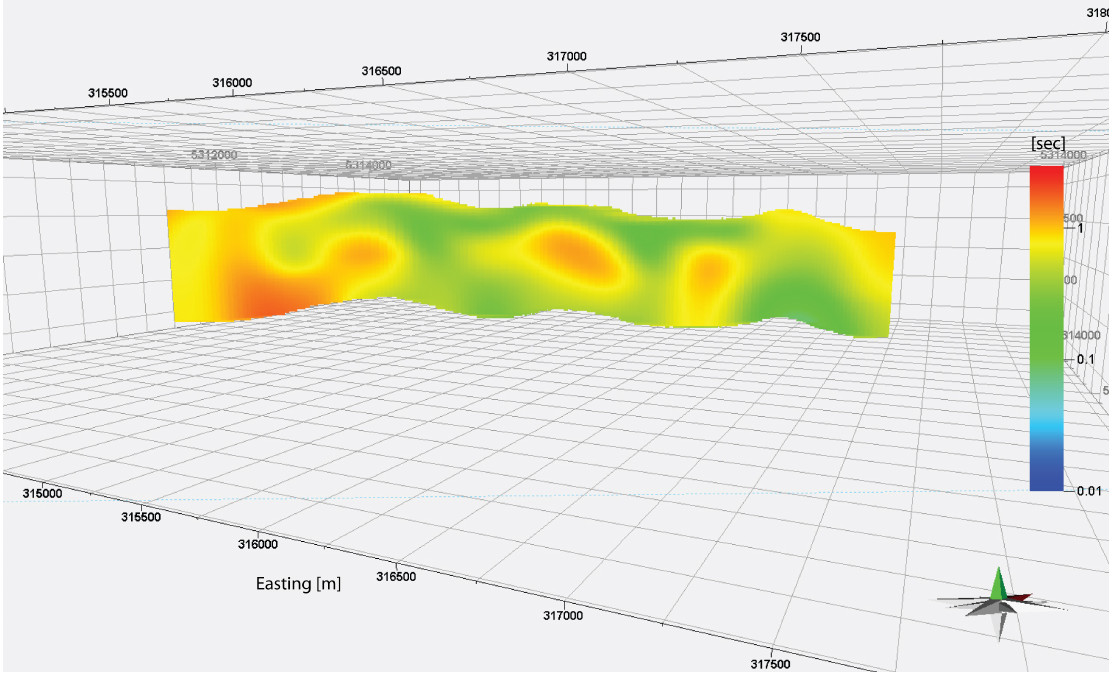
Figure 14. A vertical cross section of the 3D time constant model recovered from 3D inversion of the pole–dipole IP data along Line 1.